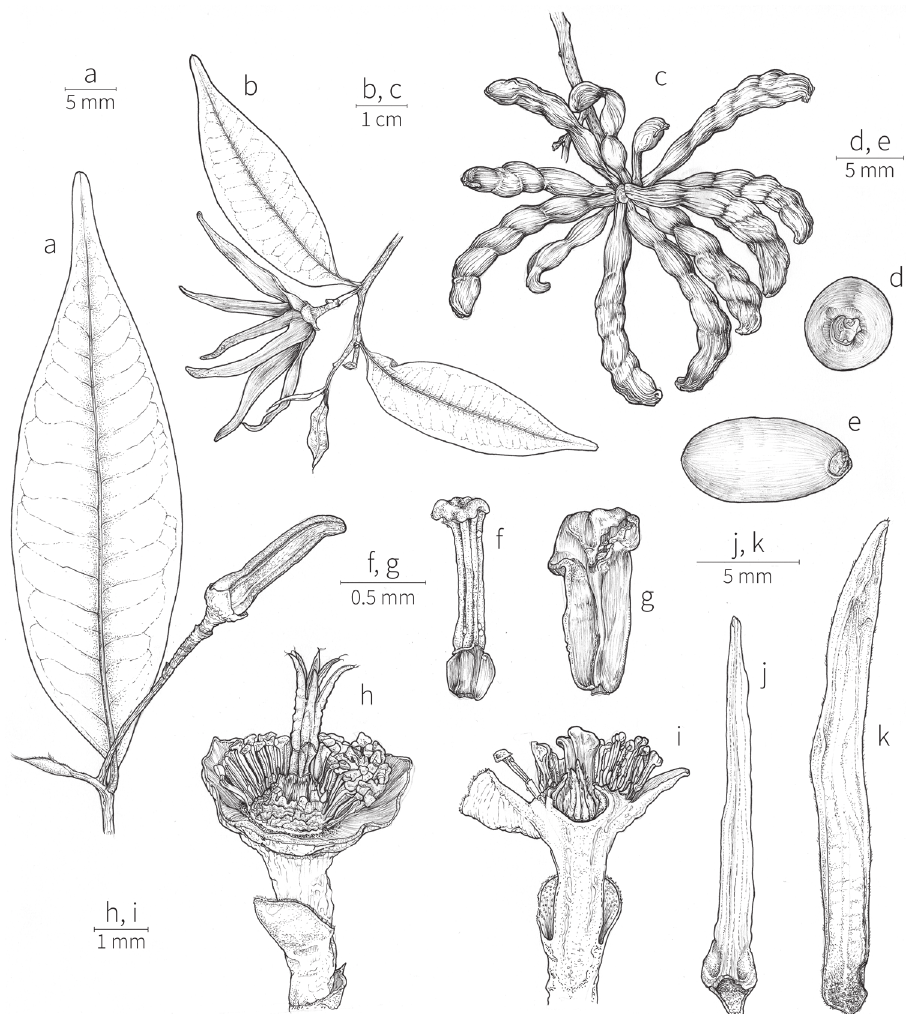
Figure 31. Xylopia wilwerthii A Habit with nearly mature flower bud B Habit, with open flower C Fruit, side view D Seed, view of micropylar end E Seed, side view F Fertile stamen, abaxial view G Staminode, abaxial view H Flower with petals and some stamens removed, side view I Longitudinal section of flower, with petals removed, showing ovaries surrounded by staminal cone J Inner petal, adaxial view K Outer petal, adaxial view. A, C from Carrington 7 (K) B, F–K from Donis 2041 (BR) D, E from Trochain 9603 (P). diameter, 0.6–0.9 mm high, partially to completely concealing the ovaries, rim lacini- ate. Carpels 6–13; ovaries 0.8–0.9 mm long, oblong, pubescent, stigmas